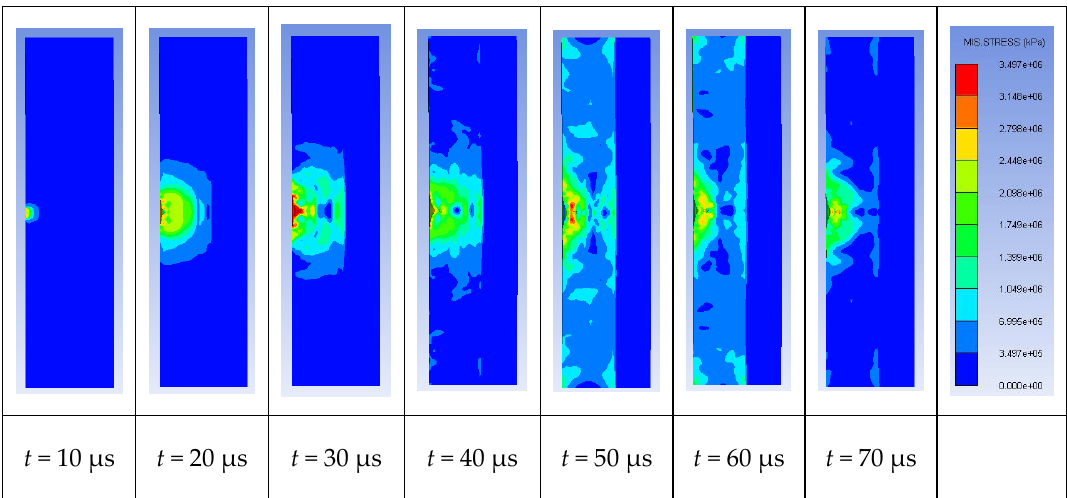
Figure 17. Stress distribution patterns of Configuration A panel at time between 10 μs and 70 μs at initial projectile velocity of 800 m/s.